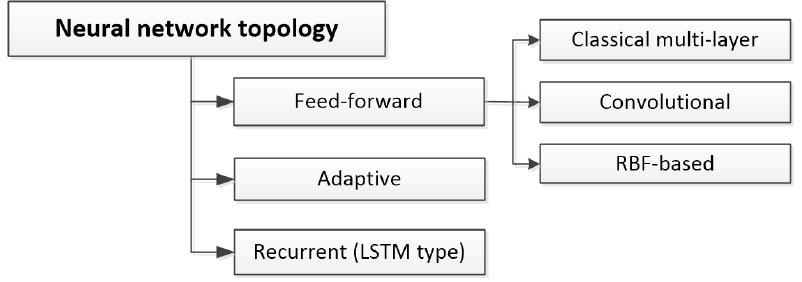
Figure 17. Neural network topologies in research on hydraulic